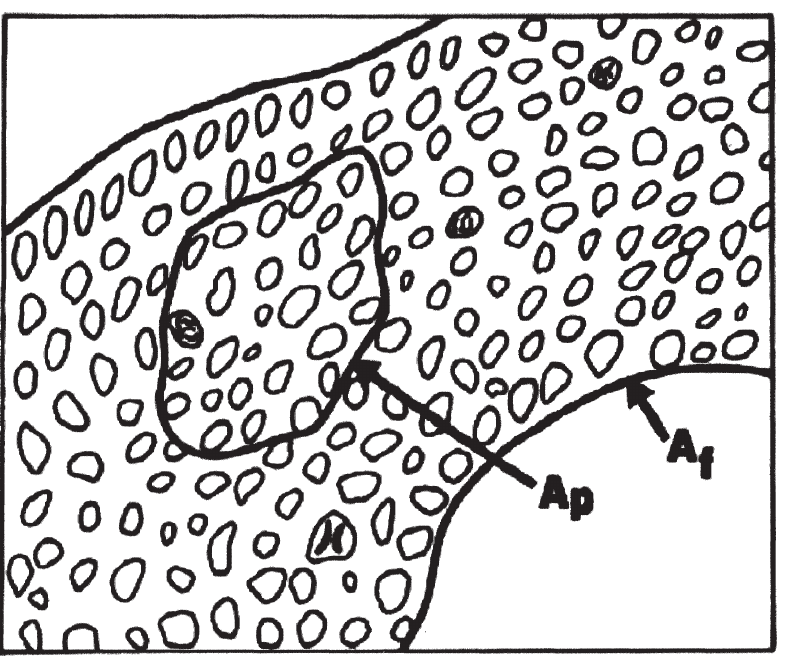
Fig. 5. The tumour epitherium ( A f ) and a representative part of it ( A p ) are marked. The number of mitoses in A f is 4 = ( MA n f